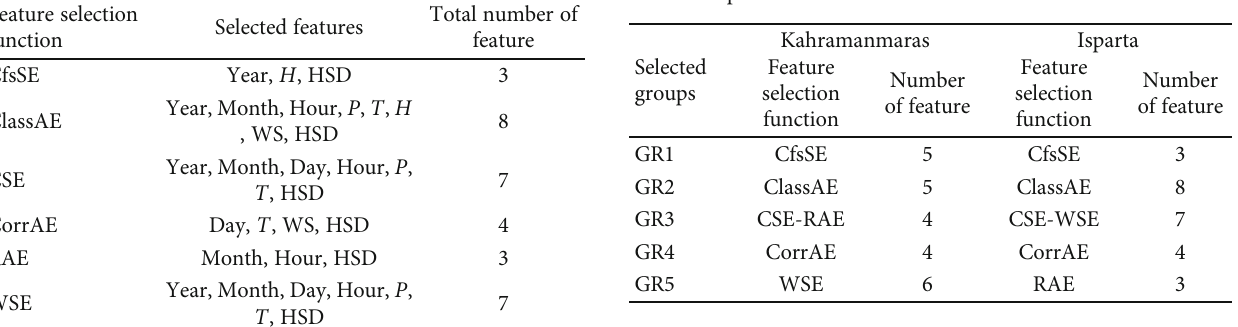
Table 7: Final data groups created to be used in estimation models of the two provinces.